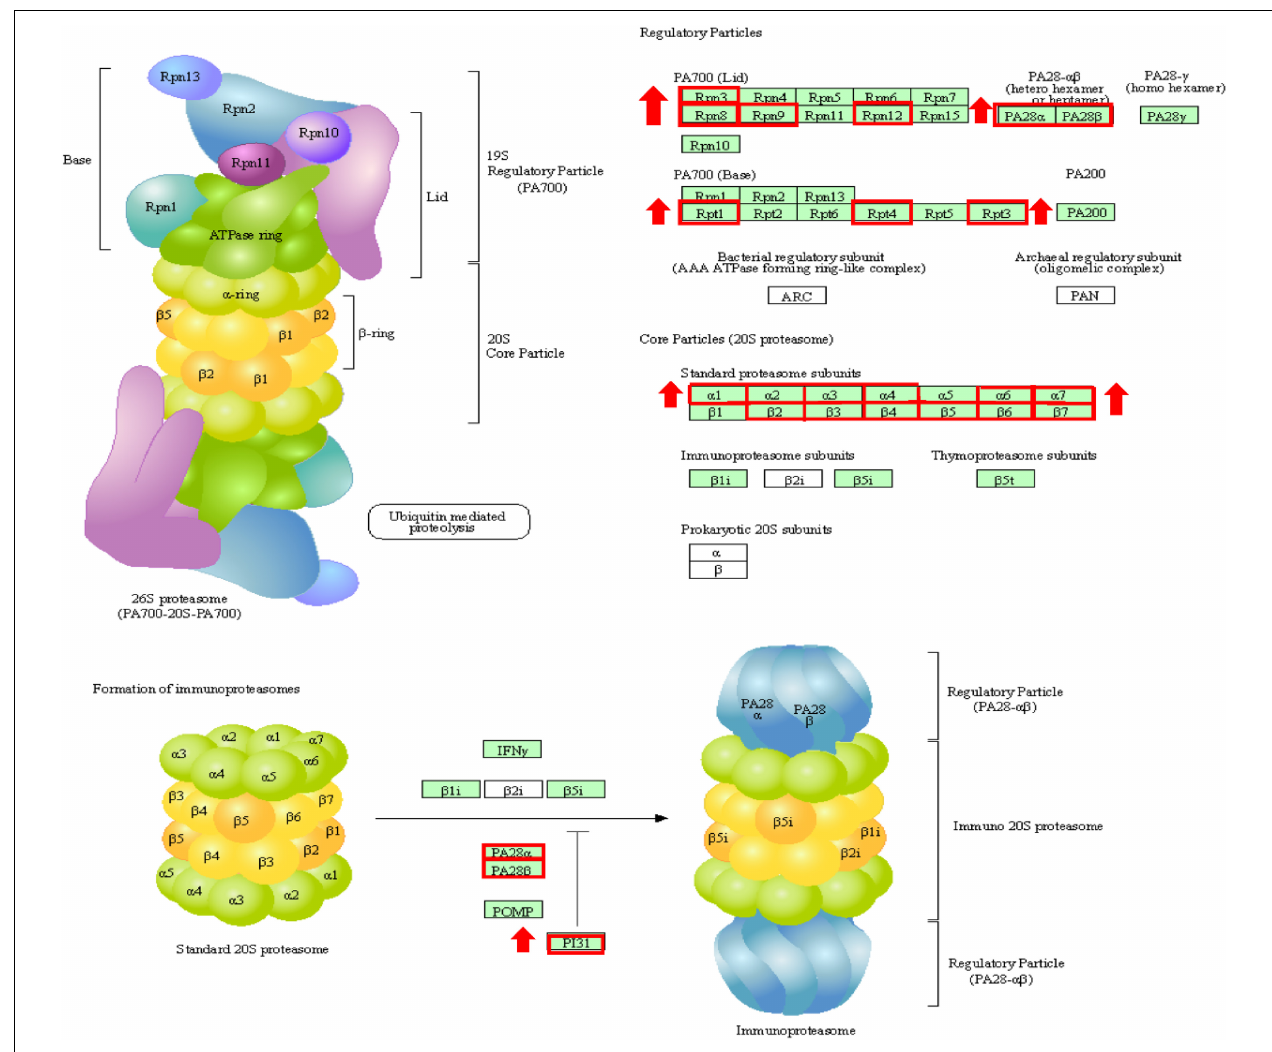
FIGURE 7 | The changes of proteasome during reoxygenation 12 h. Red boxes are genes with increased